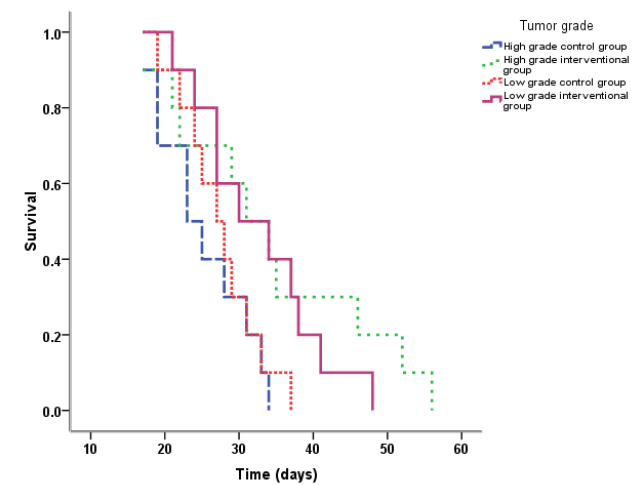
Figure 2. Kaplan–Meier plot for cumulative survival of mice carrying high- and low-grade NMIBC in control and interventional groups.